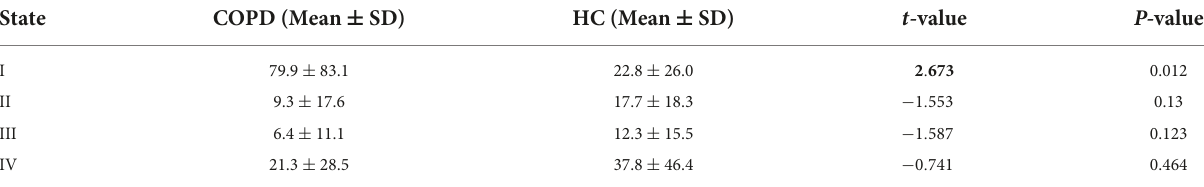
TABLE 3 Two sample t -tests of mean dwell time between the patients with COPD and HC.